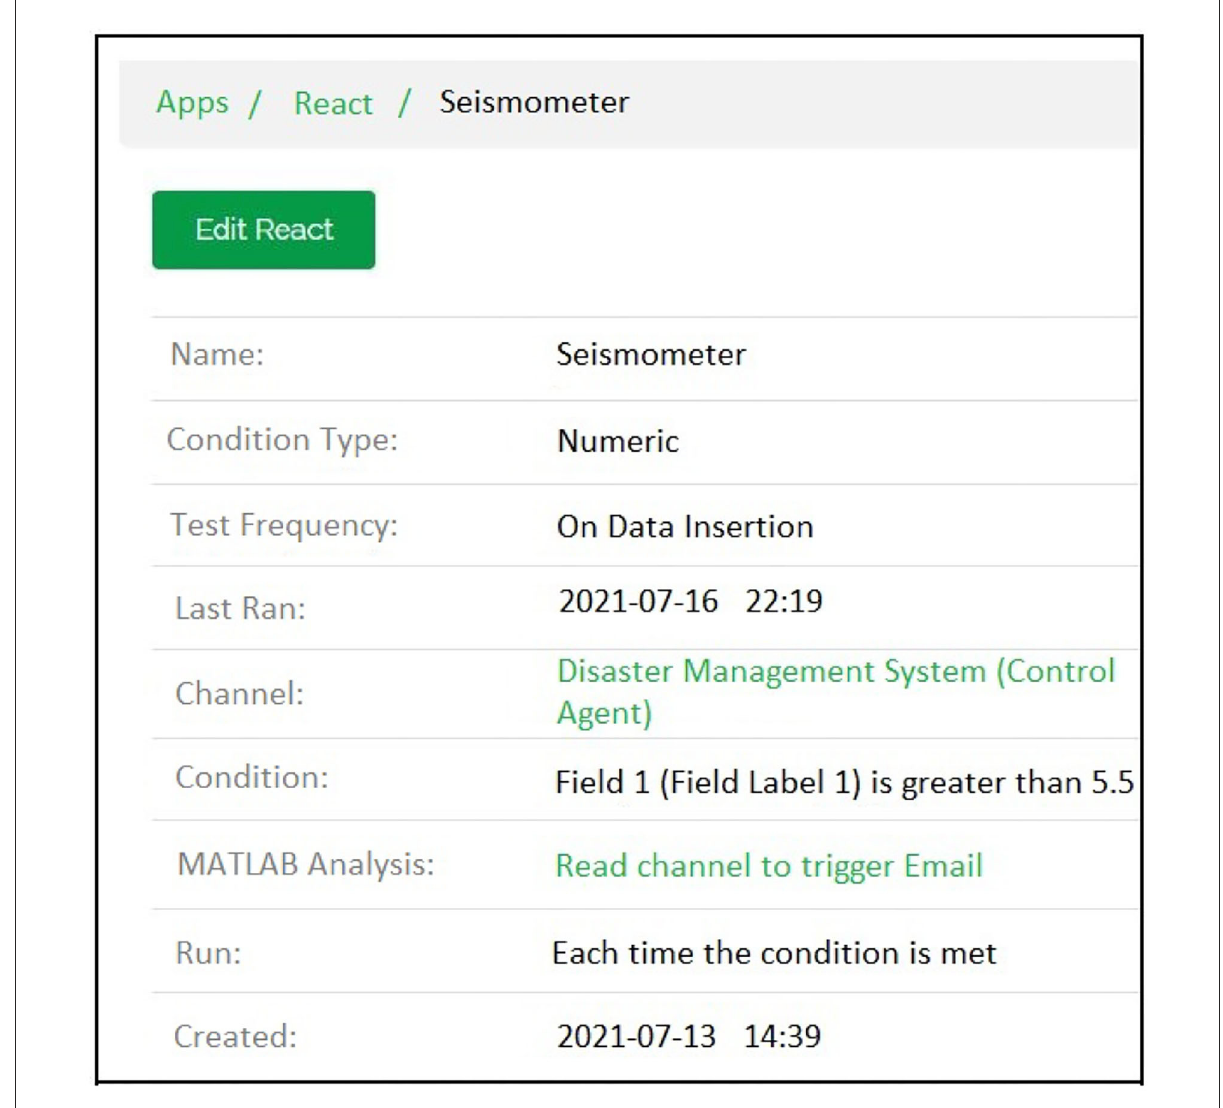
FIGURE10 Email generation react created for connecting the MATLAB code with the ThingSpeak